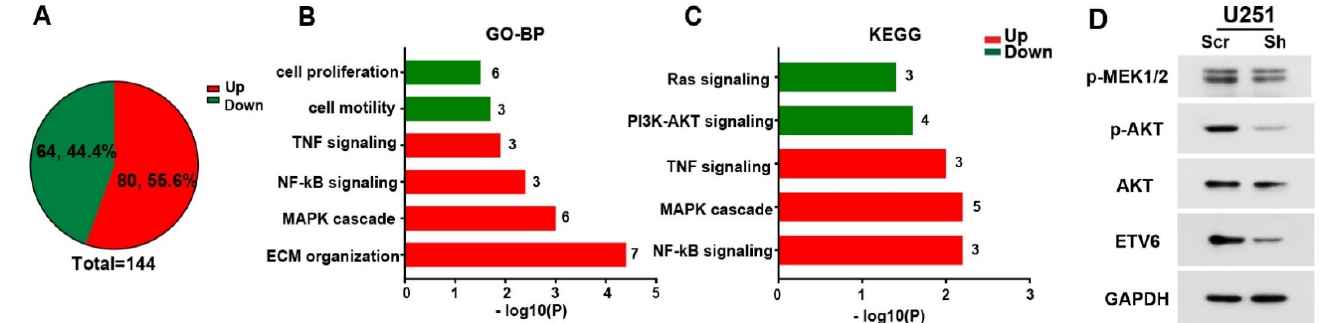
Figure 4. Differentially regulated transcriptional network in ETV6-silenced GBM cells. ( A ) A total of 80 upregulated and 64 downregulated genes were differentially expressed upon ETV6 knockdown via shRNA in U251 cells. p < 0.05, log2FC > 1 or < − 1. ( B , C ) Gene ontology (GO) enrichment and KEGG pathway analyses were performed using Enrichr. Representative upregulated (red) and downregulated (green) terms are shown. Gene numbers involved in each term are indicated. ( D ) Immunoblotting of validation on Ras pathway ( p -MEK1/2) and PI3K-AKT pathway ( p -AKT and AKT) in ETV6 silenced U251 cells.